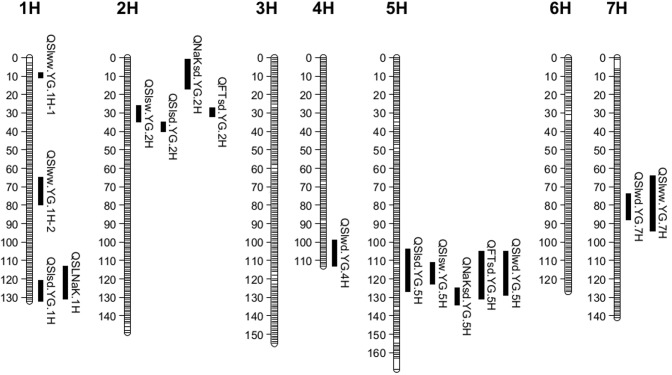
QTL associated with salinity tolerance, flowering time and leaf Na/K ratio.Map distances in centiMorgan (cM) are on the left.